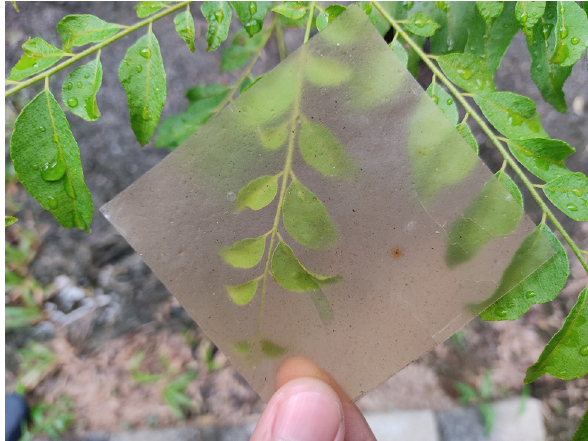
Figure 1: Transparent fi lm of CEO - reinforced SPN/SPS biocompo - site fi